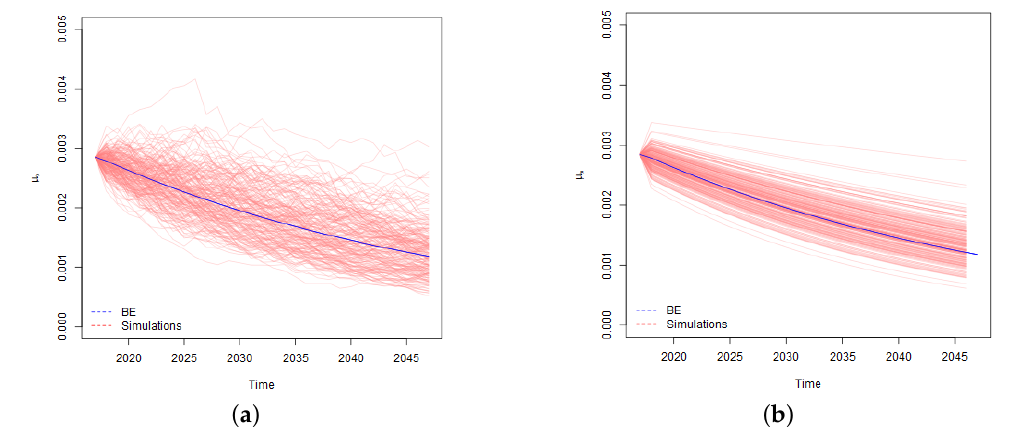
Figure 1. Example of simulations of central mortality rates (for a fixed age) used for the purpose of calculation of run-off VaR (see ( a )) and one-year VaR (see ( b )). The calculations are based on the Lithuanian data for a life aged 40 years. In calculations of one-year VaR reserve sensitivity parameter δ = 10% was